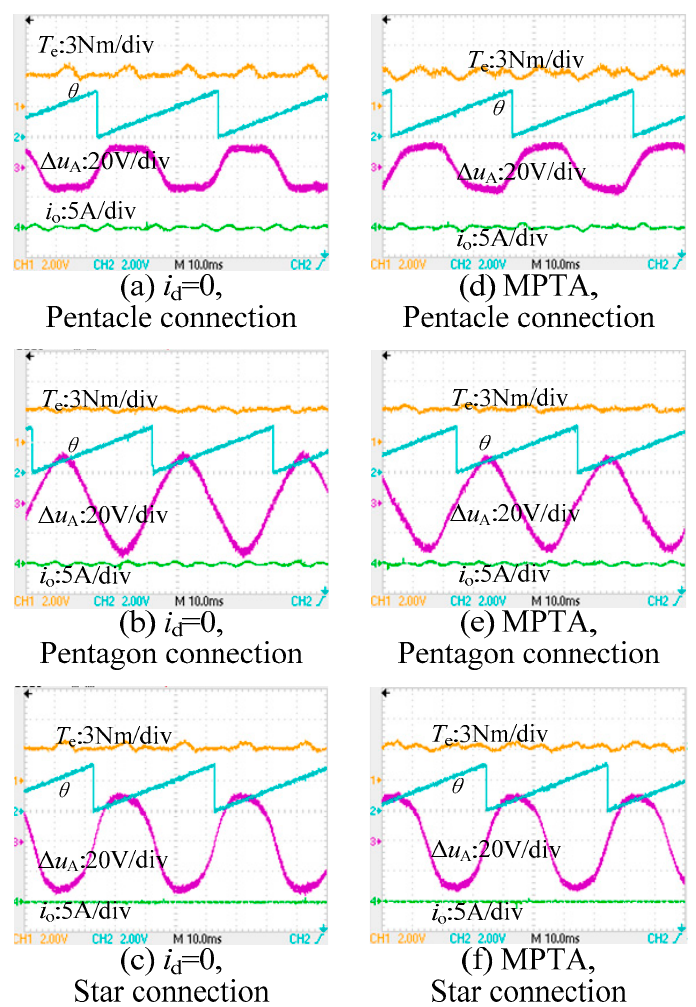
∆ u Figure 9. Waveforms of Δ u A , i o , T e , and θ under a single open-line fault. Figure 9. Waveforms of A , i o , T e , and θ under a single open-line